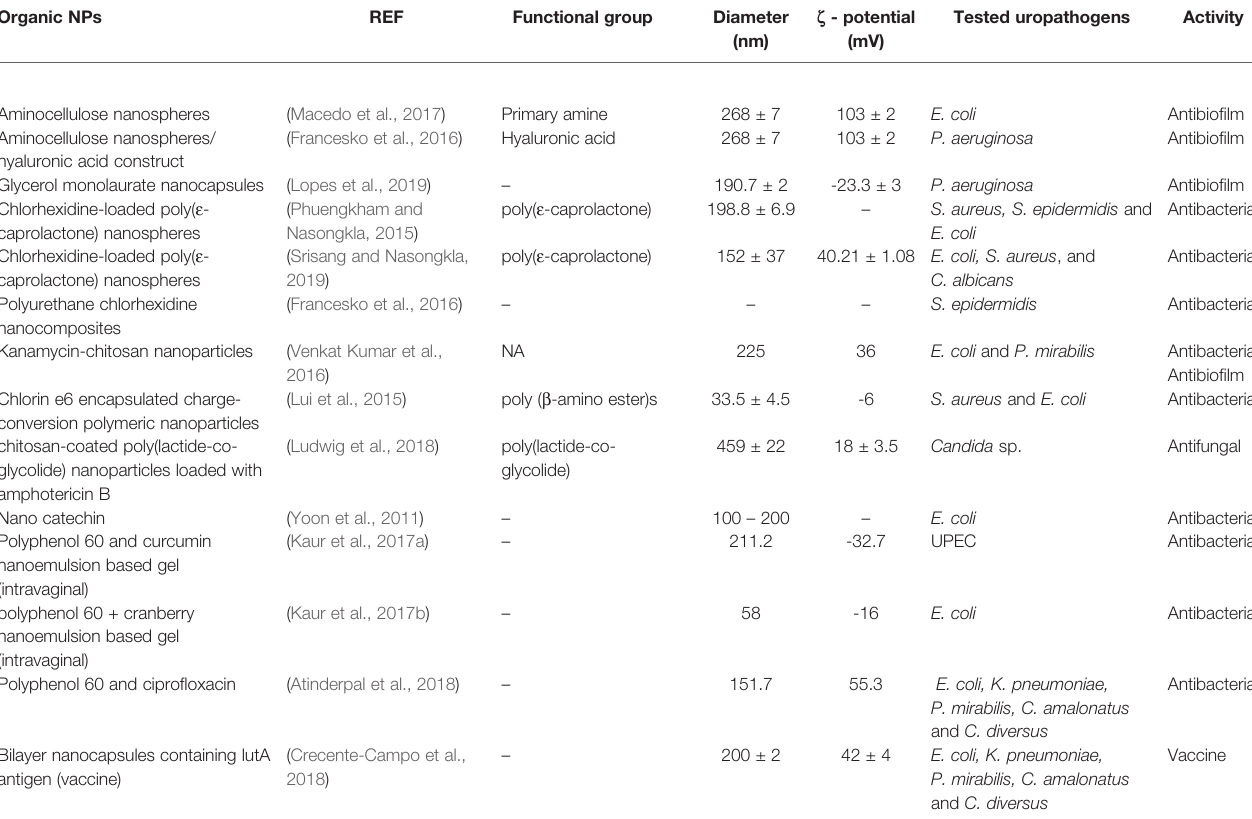
TABLE 1 | Physicochemical characteristics of organic